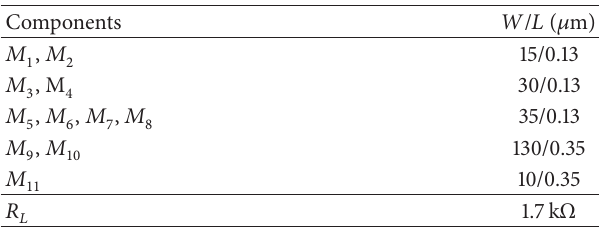
Table 1: Simulation parameters used for the proposed mixer of Figure 2.